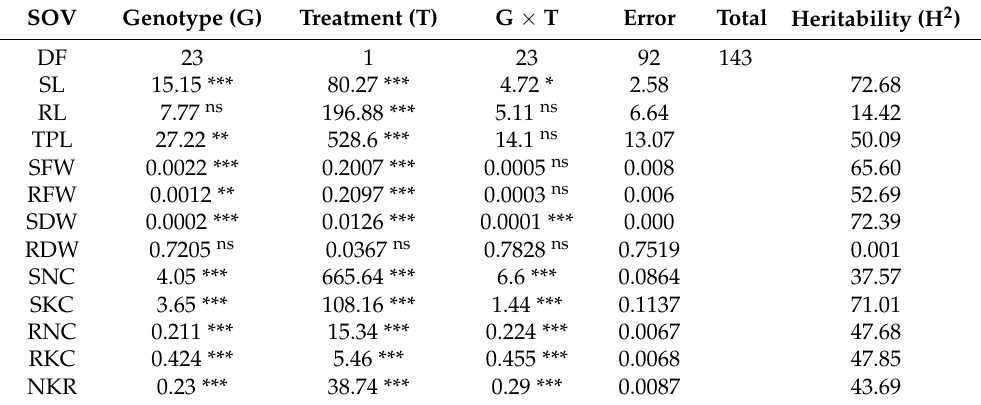
Table 1. Mean squares values from analysis of variance (ANOVA) for 12 seedling-related parameters of